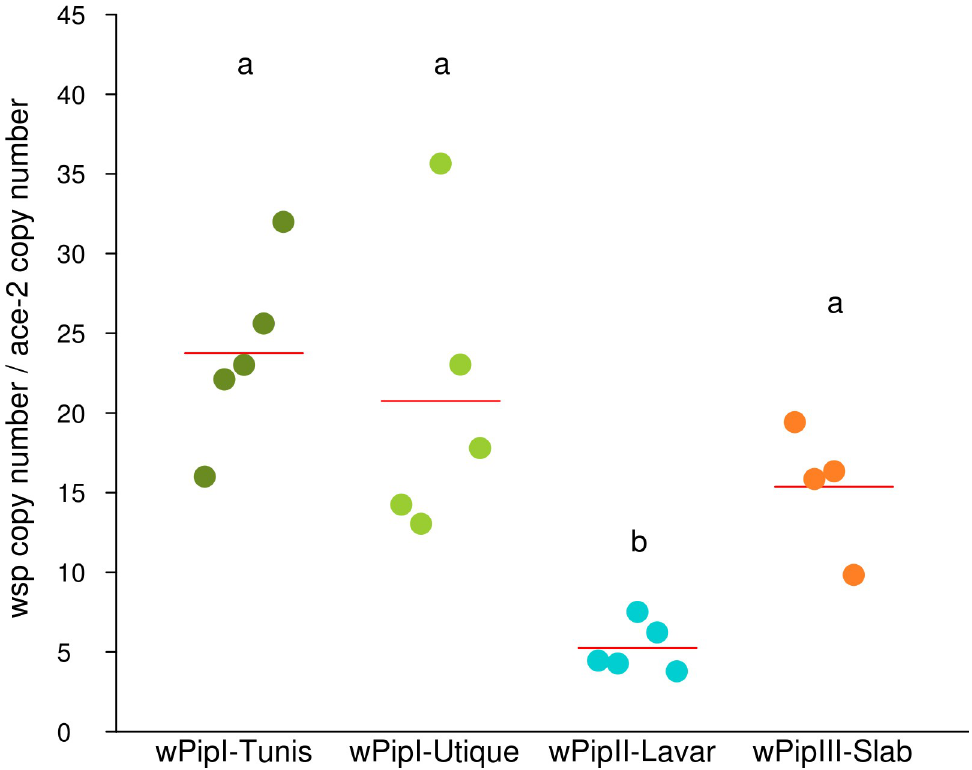
Fig 5. Wolbachia density in testes. Wolbachia densities in mosquito testes were measured by quantitative PCR as the ratio between the number of copies of the Wolbachia wsp gene and the C . pipiens ace-2 nuclear gene. The colored dots represent the average density of Wolbachia in a pool of three pairs of testes and the red strips represent the average Wolbachia density for each line/ w Pip strain. Letters represent the different statistical groups ( i . e . means with the same letter are not significantly different), showing that Lavar males harbored significantly less Wolbachia in their testes than the other